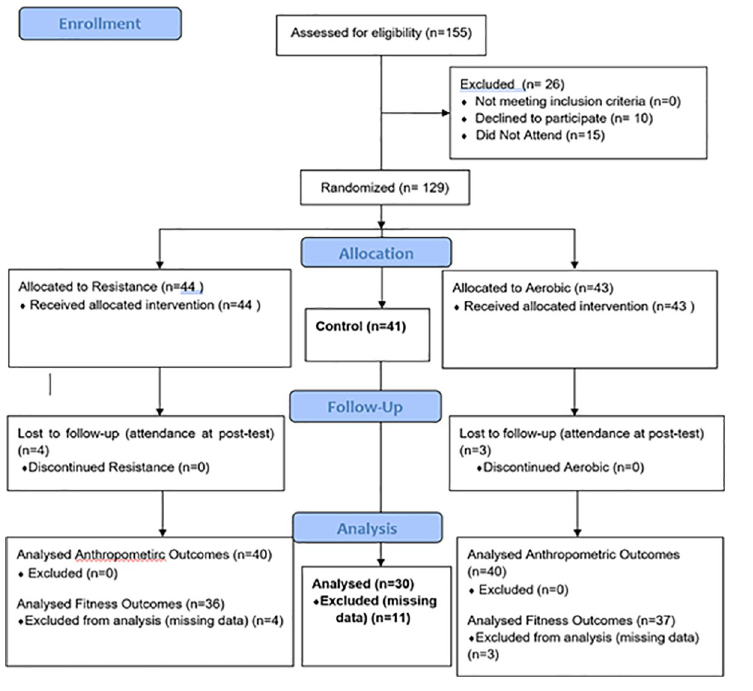
Fig 5. Consort 2010 flow diagram.